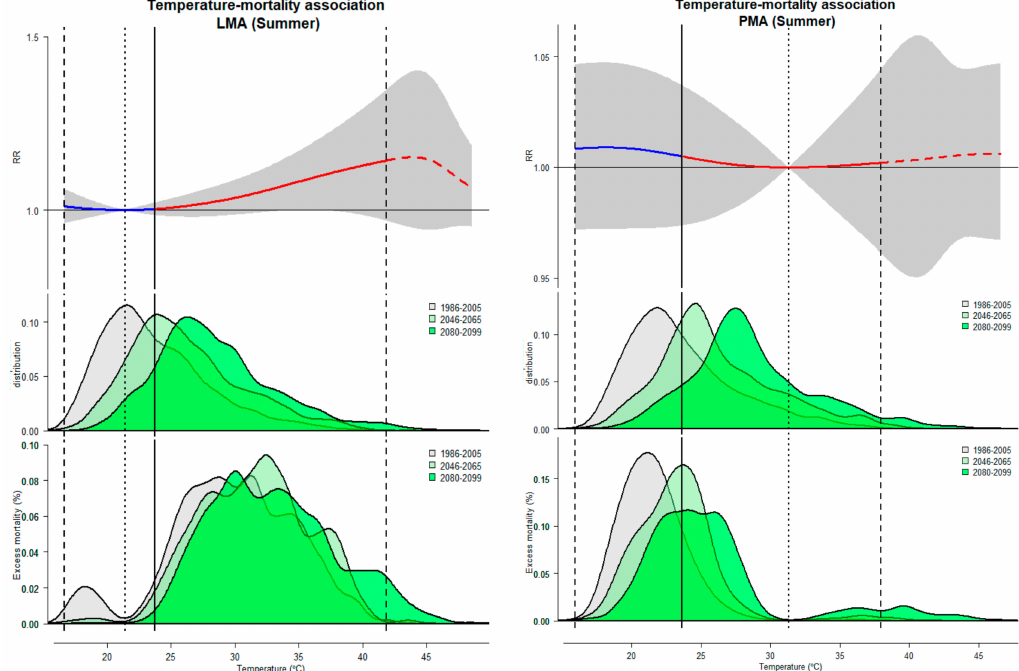
Figure 7. Temperature and excess mortality for the historical and future periods in the study region during the summer period. Top panel: Exposure–response curve for temperature–mortality relative risk (RR), with the blue and red lines representing cold and hot, respectively, together with their 95% CI in grey. The solid vertical line corresponds to the mean temperature that divides the curve into cold and hot, while the dotted represents the reference temperature (MMT). The dashed red line represents the extrapolation beyond the maximum temperature in 1986–2005 (broken vertical line) for the future periods. Middle panel: Temperature distribution for the historical (grey area) and future periods, 2046–2065 (green area) and 2080–2099 (darker green area). Bottom panel: Temperature-related excess mortality distribution expressed as the fraction of additional deaths (%) attributed to non-optimal temperature, compared with the reference temperature.